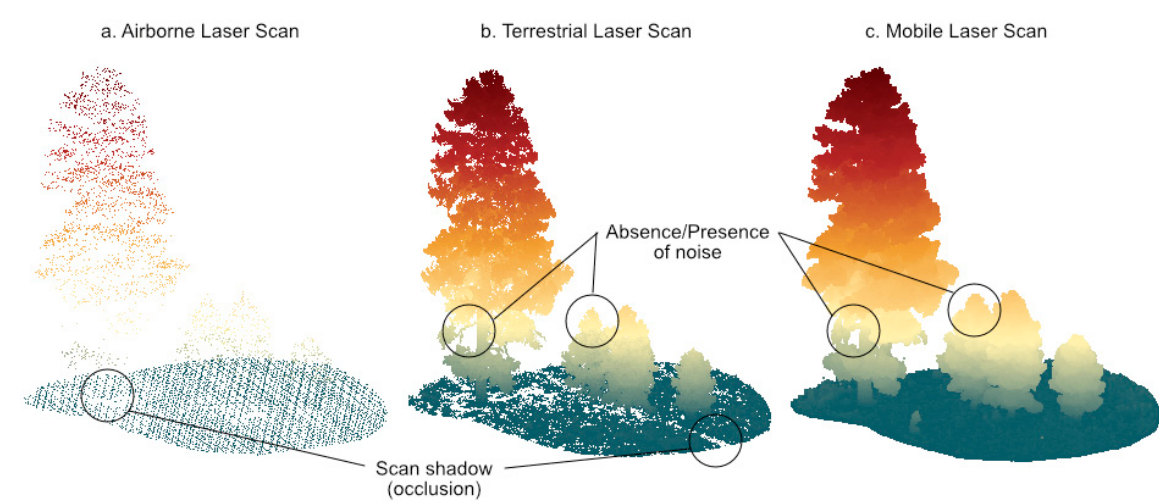
Figure 1. Example scans obtained from ( a ) airborne, ( b ) terrestrial and ( c ) mobile laser (lidar) scanning platforms for the same region of interest (depicting four trees within a plot) illustrating point density, scan shadows, and the absence/presence of noise. Average number of point returns m − 1 for each platform were ( a ) airborne: 22.4, ( b ) terrestrial: 1890.7, and ( c ) mobile: 1106.5.